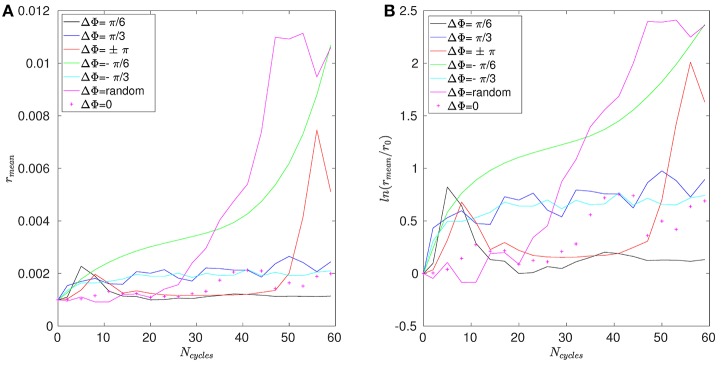
Results obtained for position B and Re = 5.10−2. (A) Average distance rmean between the fathers and the children as a function of the number of cycles Ncycles. (B) Logarithm of the dimensionless average distance rmean/r0 as a function of the number of cycles Ncycles.